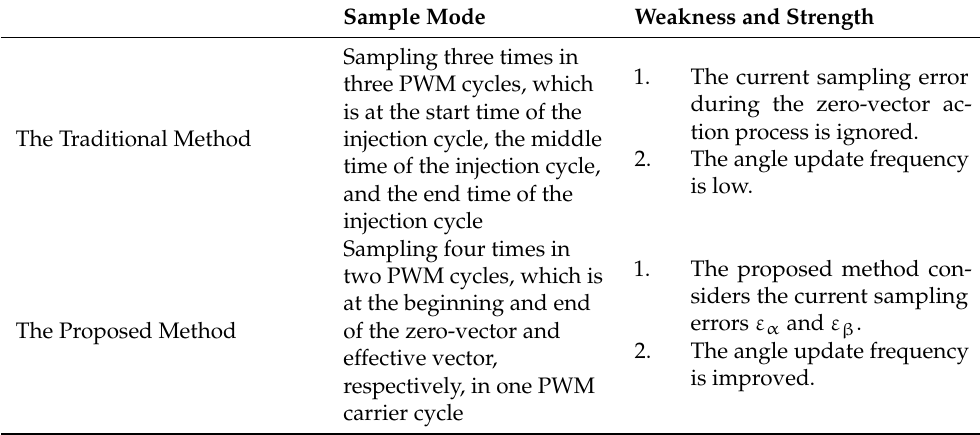
Table 1. Improvement of the proposed method.